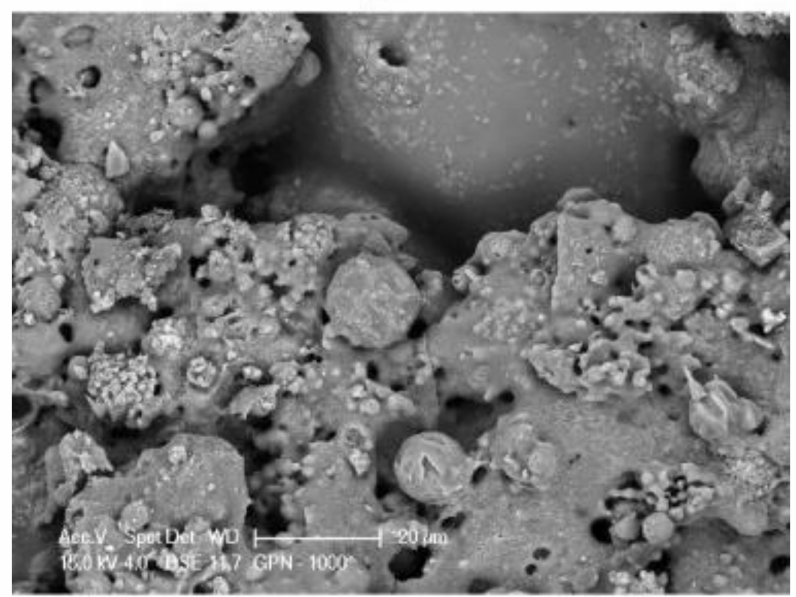
Figure 6. SEM images of geopolymer concrete after 1000 ◦ C fire exposure [83].